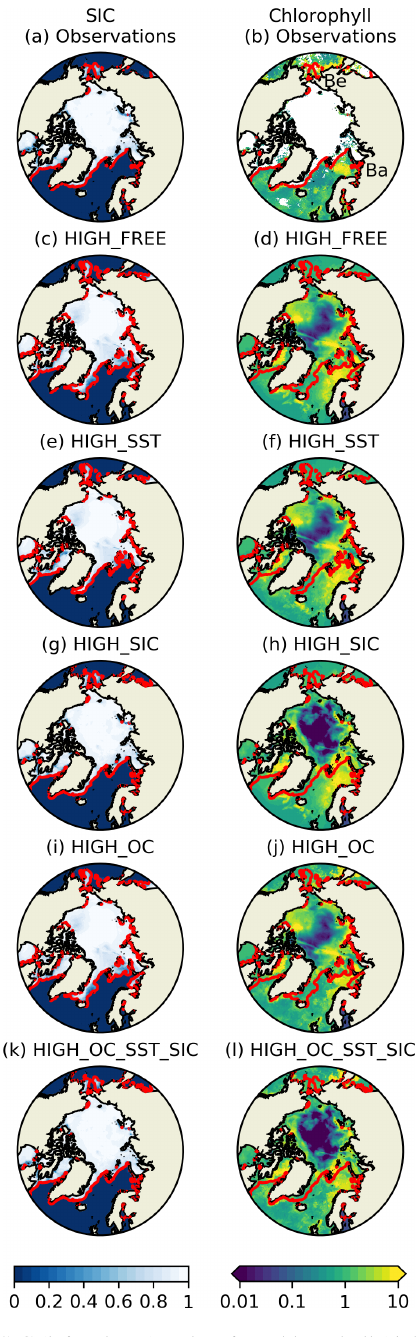
Figure 6. SIC (left column) and surface chlorophyll (right column) for 17–24 May 2010 from observed (a, b) and modelled (c–l) fields. In (b) chlorophyll blooms in the Bering Sea and Barents Sea are marked with Be and Ba,